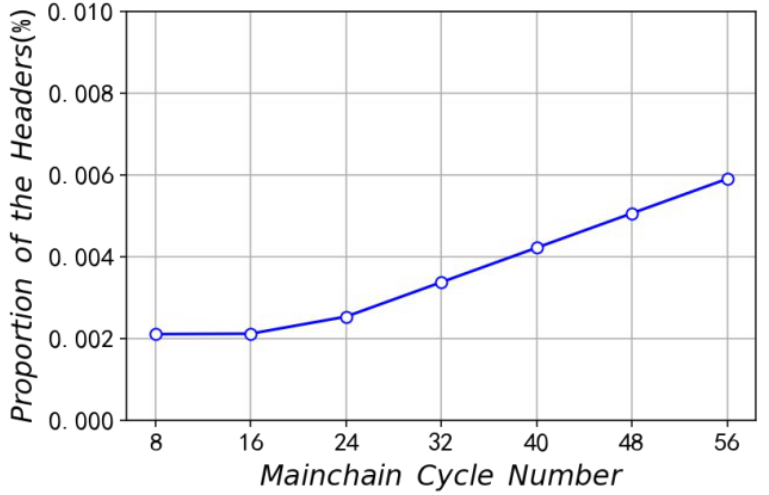
Figure 14. The proportion of sidechain data in the ledger volume of the business node.